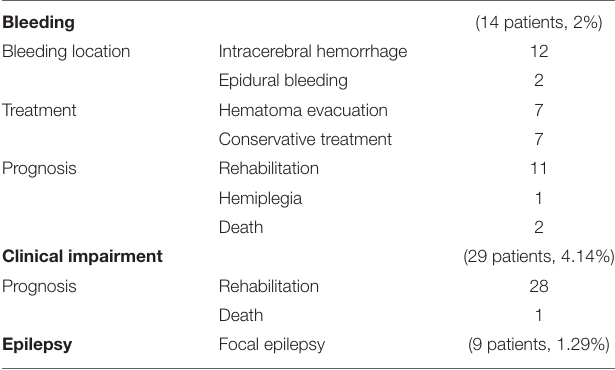
TABLE 2 | Data for postoperative complications. Bleeding (14 patients, 2%)